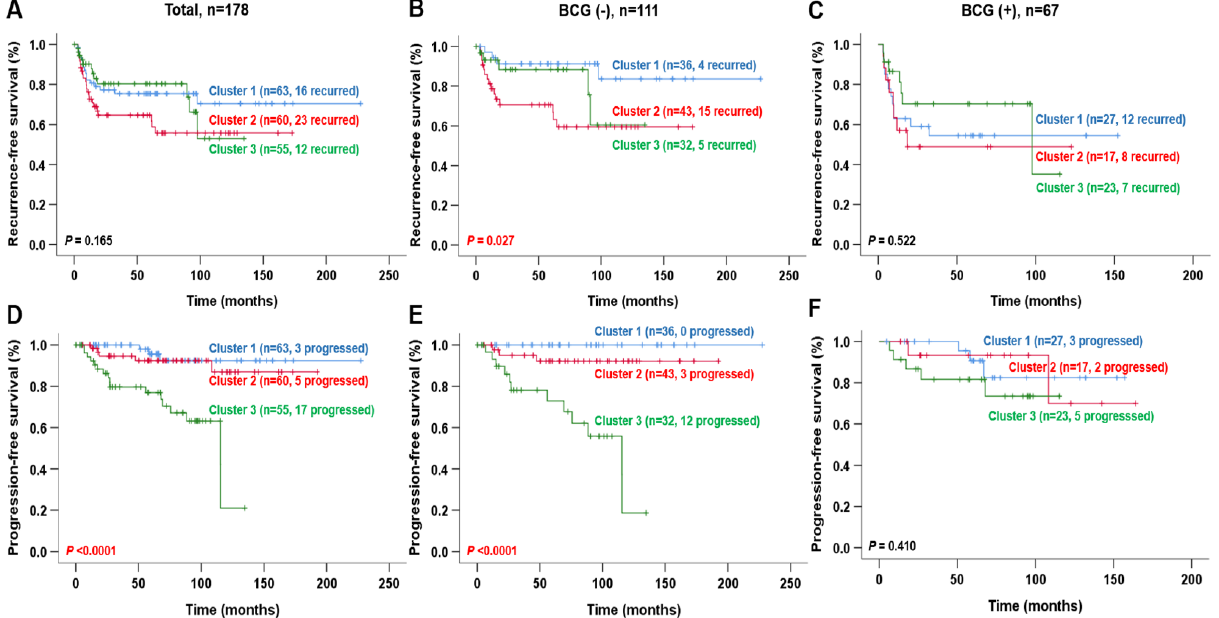
Figure 2. Kaplan–Meier survival curves for risk of recurrence and progression in the CBNUH cohort (based on MSP888 classifier). ( A – C ) Recurrence − free survival according to MSP888 classifier. ( D – F ) Progression − free survival according to MSP888 classifier. ( A , D ), all patients; ( B , E ), patients without BCG treatment; ( C , F ), patients with BCG treatment. BCG, Bacillus Calmette − Guérin; CBNUH, Chungbuk National University Hospital; MSP888, a molecular signature − based subtype predictor comprising Cluster 1 (EP, equivocal prognosis), Cluster 2 (REC.BCG+, related to recurrence and response to BCG treatment) and Cluster 3 (DP.BCG+, related to progression and response to BCG